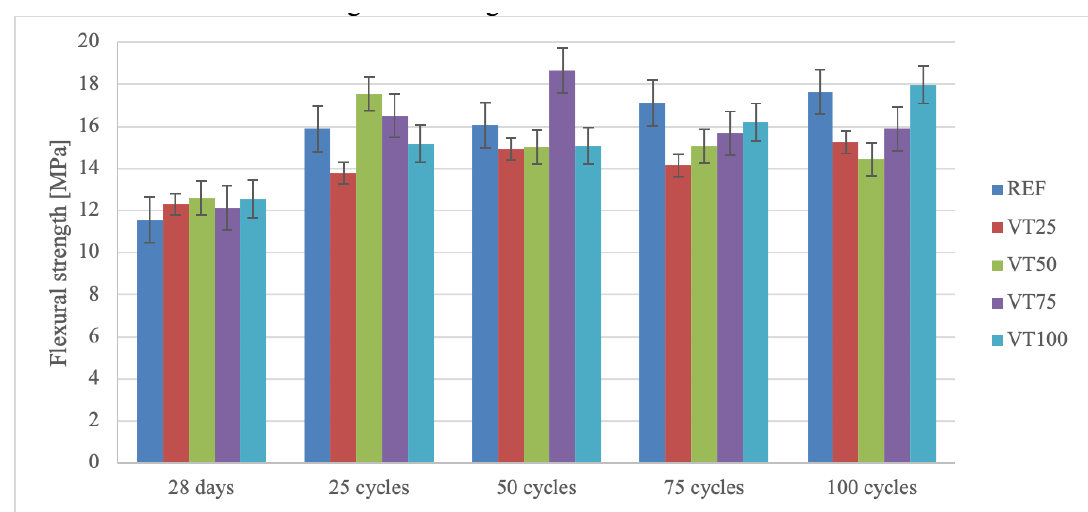
Figure 1. Flexural strength values after freeze-thaw resistance experiment.